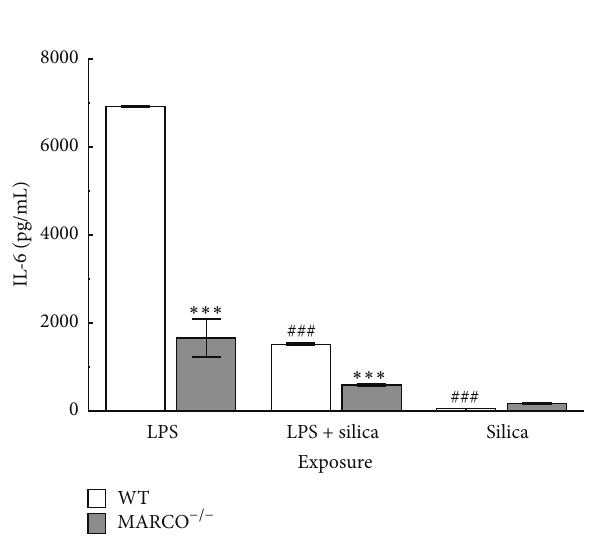
Figure 6: Effect of inflammasome activation on IL-6 release. IL- 6 release from WT and MARCO −/− AM in response to silica (100 𝜇 g/mL), LPS (20ng/mL), or silica and LPS. Mean ± SEM IL- 6 from cultured AM where white bars indicate WT AM and grey barsindicateMARCO −/− AM.Tripleasterisk ∗∗∗ indicates 𝑃 < 0.001 comparedtoWTatcorrespondingtreatment, ### indicates 𝑃 < 0.001 compared to control in the corresponding mouse strain, 𝑛 = 3 per experimental group.